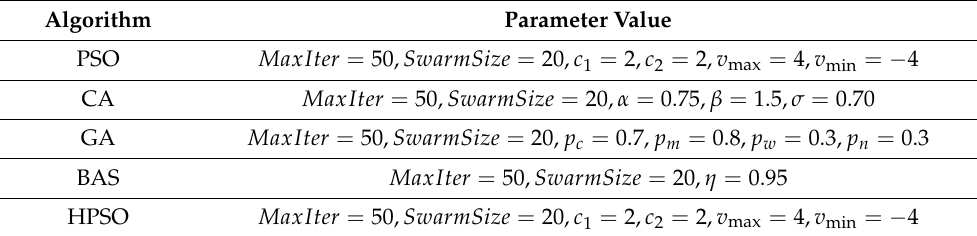
Table 1. Parameters of different